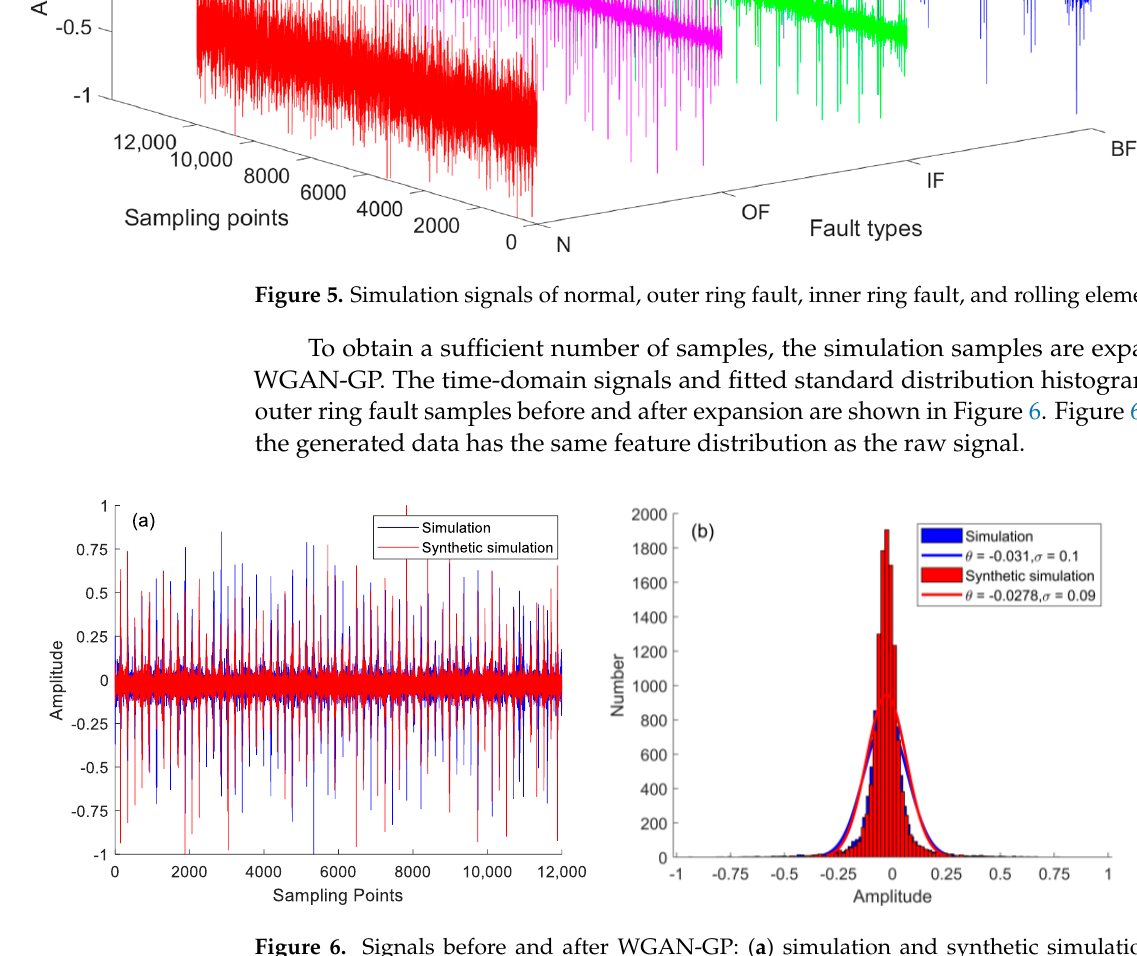
Figure 6. Signals before and after WGAN-GP: ( a ) simulation and synthetic simulation signals; ( b ) normal distribution and corresponding fit of simulation and synthetic simulation signals.